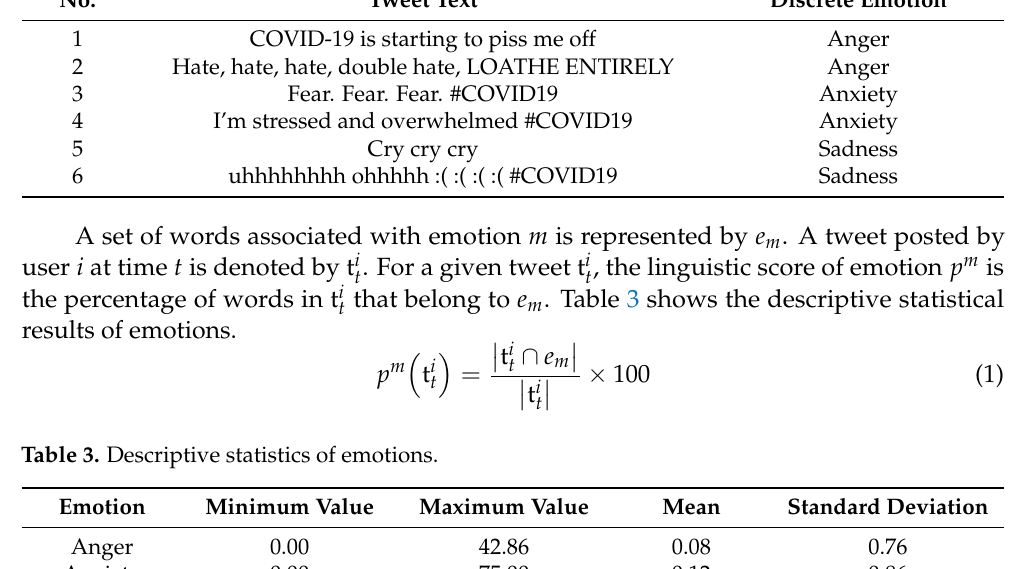
Table 2. Examples of discrete emotions identified from tweets using LIWC. No. Tweet Text Discrete Emotion 1 COVID-19 is starting to piss me off Anger 2 Hate, hate, hate, double hate, LOATHE ENTIRELY Anger 3 Fear. Fear. Fear. #COVID19 Anxiety 4 I’m stressed and overwhelmed #COVID19 Anxiety 5 Cry cry cry Sadness 6 uhhhhhhhh ohhhhh :( :( :( :( #COVID19 Sadness